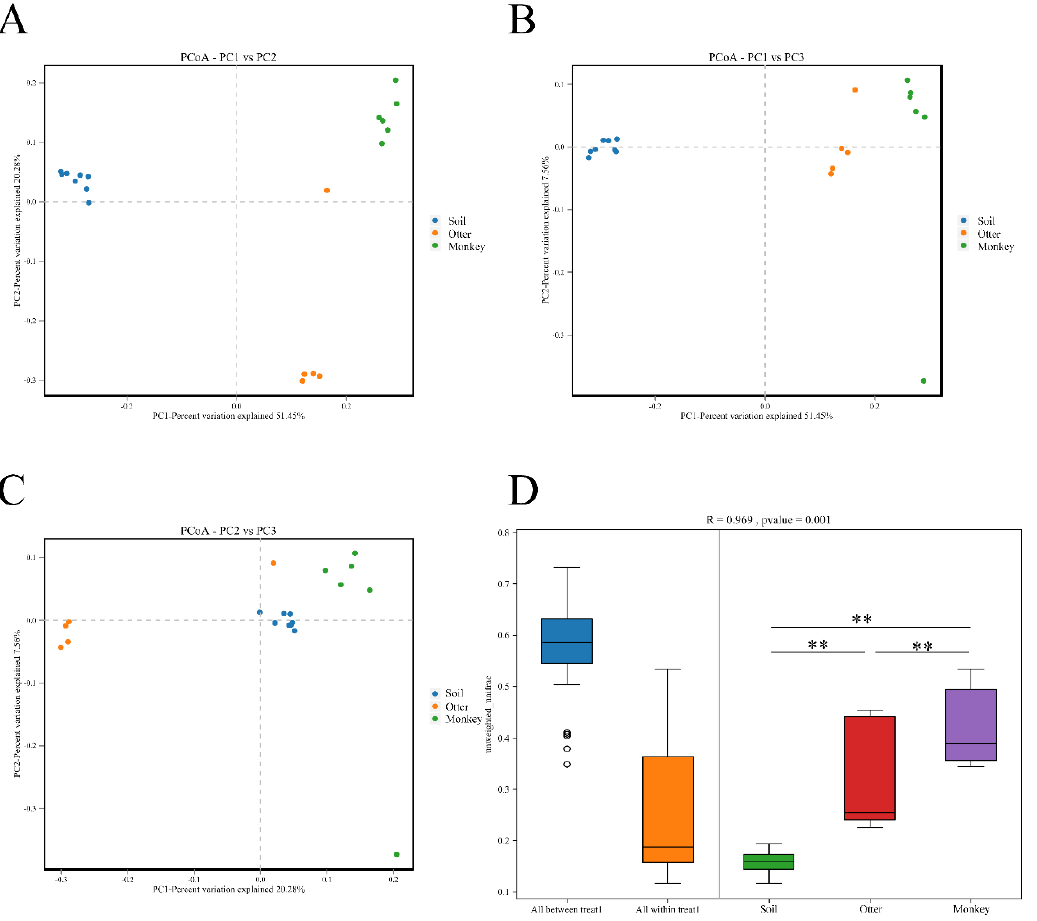
Figure 5. Beta diversity (unweighted UniFrac distances) of the habitat soil microbiome and gut microbes of Eurasian otters and golden snub-nosed monkeys. ( A – C ) represented PcoA PC1 vs. PC 2, PC1 vs. PC3, and PC2 vs. PC3, respectively. ( D ) Box diagram of PERMANOVA/Anosim. ** p < 0.01.